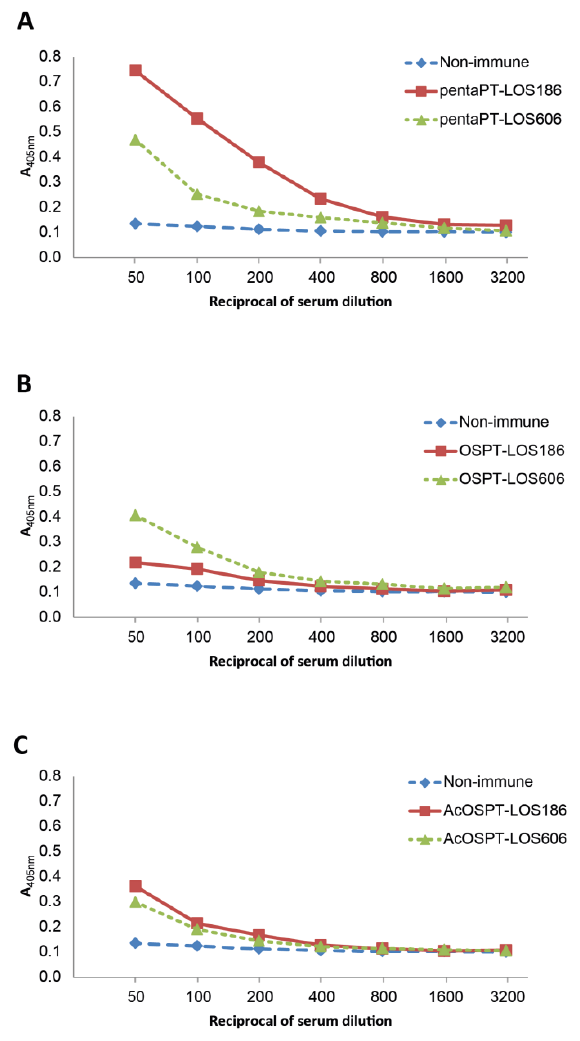
Figure 4. Reactivities of polyclonal antibodies against penta-PT ( A ), OS-PT ( B ), AcOS-PT ( C ) with LOS of B. pertussis 186 and 606 in ELISA. Non-immune sera were used as control. The mice sera (10 mice/group) were pooled for groups of antigens. A sample from a pool for each group was initially diluted 50-fold and tested as 2-fold serial dilution in ELISA. B. pertussi s LOS of strains 186 and 606 were used as a solid phase. LOS of strain 606 is devoid of a distal trisaccharide. The standard deviations did not exceed 10% and are not shown.